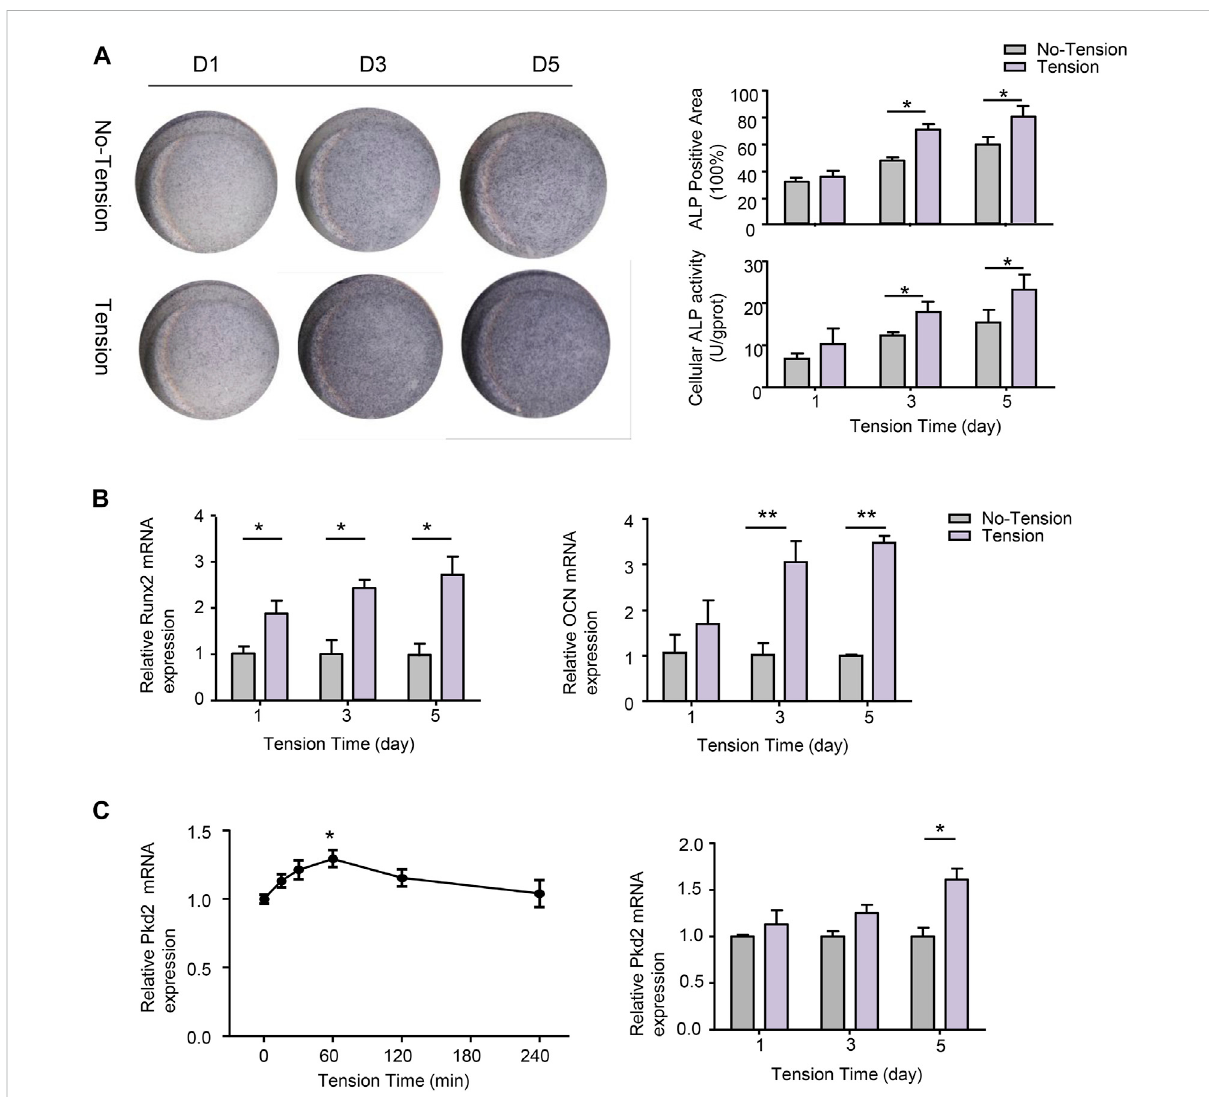
FIGURE 3 Effect of mechanical tension on osteogenic differentiation of hASCs. (A) hASCs were subjected to 1-, 3-, or 5-day ’ s mechanical tension. ALP staining was performed to visualize the osteogenic ability of hASCs.ALP + areas were measured by ImageJ. Cellular ALP activity was detected by colorimetric assay (B) Osteogenic-speci fi c makers Runx2 and OCN were detected at mRNA levels with real-time PCR after 1-,3-, or 5- day ’ s mechanical tension. GAPDH was used for normalization (C) After 0, 15, 30, 60, 120, or 240-min ’ s mechanical tension and 1-,3-, or 5- day ’